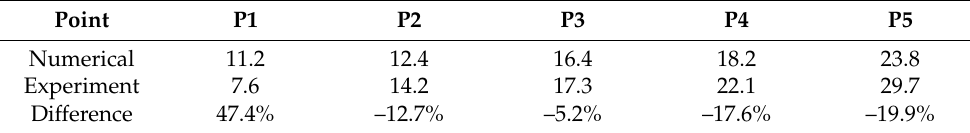
Table 8. Comparison of slamming duration